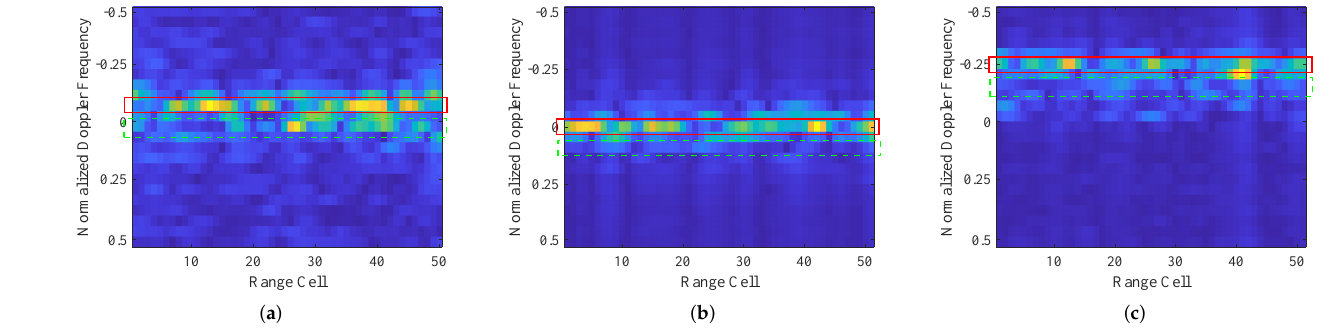
Figure 5. R-D spectrum of the three types of clutter. In the figure, the red solid box and the green dotted box, respectively, represent the area where the target is located: if the data is dealt with MTI or AMTI in the pre-processing stage, targets fall in the green dotted box; otherwise, targets fall in the red solid box. ( a ) Type-1; ( b ) Type-2; ( c ) Type-3.